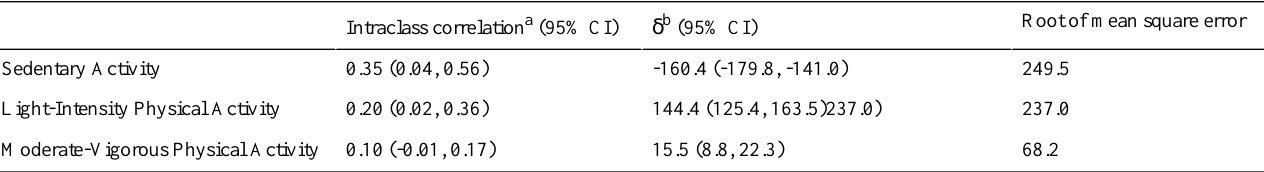
Table 1. Agreement between activPAL3c and the BeWell24 app.